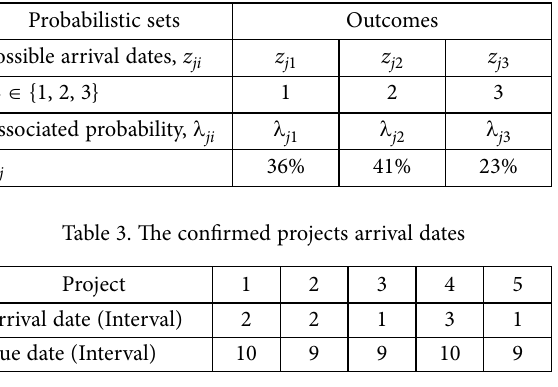
Table 2. The probabilistic arrival dates with their associated